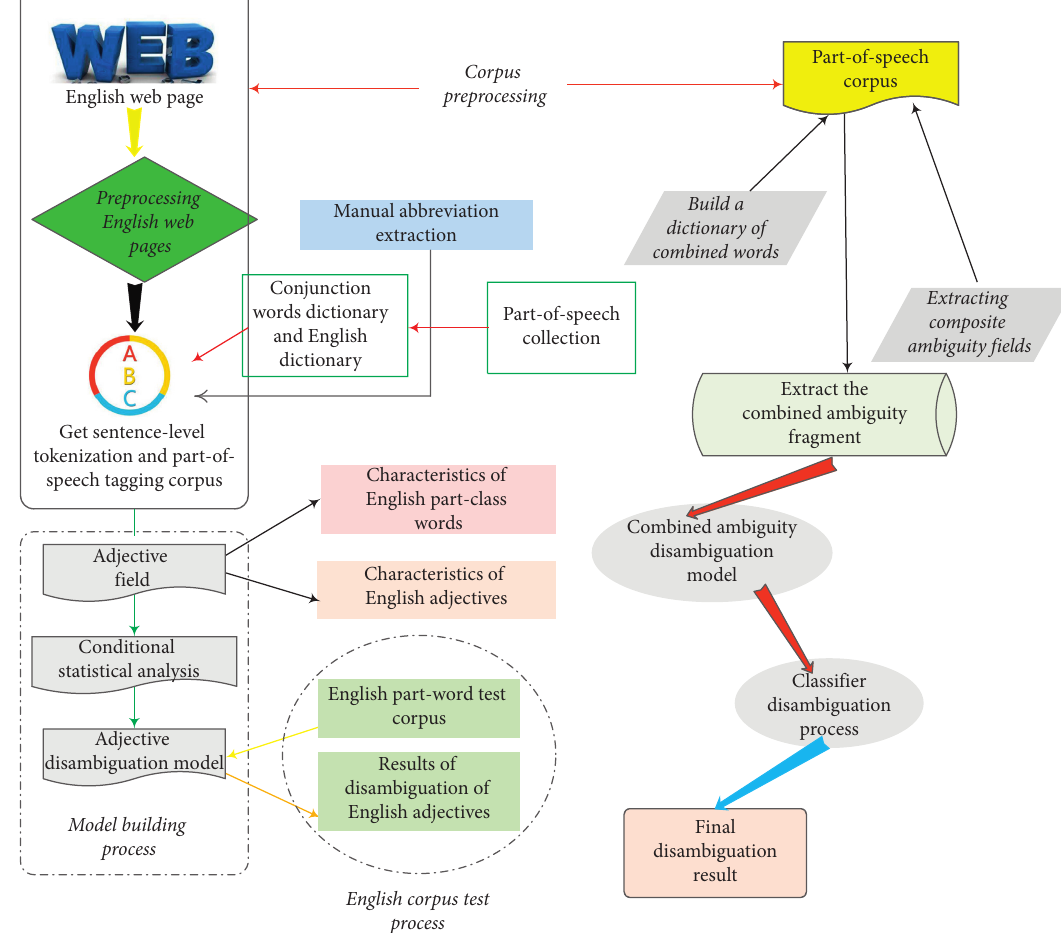
Figure 2: English combination ambiguity resolution